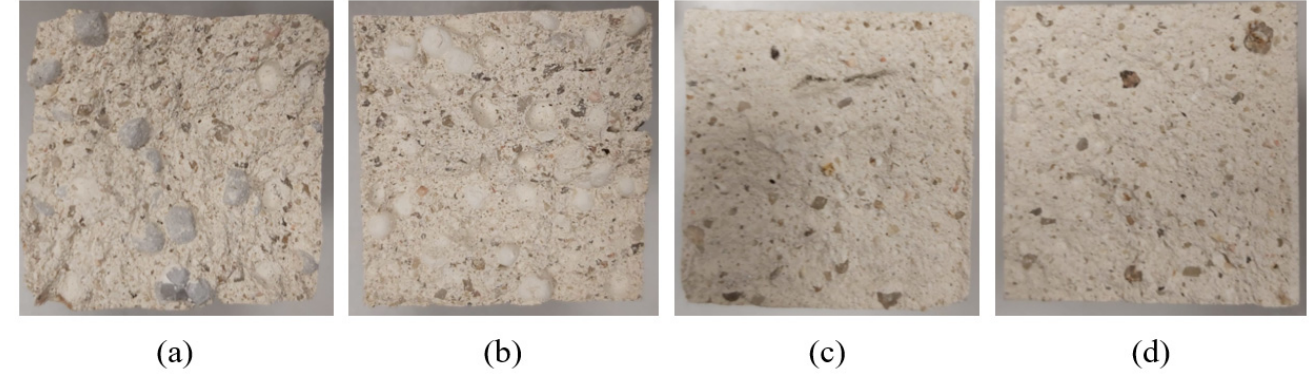
Figure 4. Breakage of the specimens after the flexural test. ( a ) LM-EPS-F-2.5; ( b ) LM-EPS-I-2.5; ( c ) LM-MW-2.5; ( d ) LM-REF. Table 6. Comparison for flexural strength (MPa) between mortars with incorporation of insulating residue.